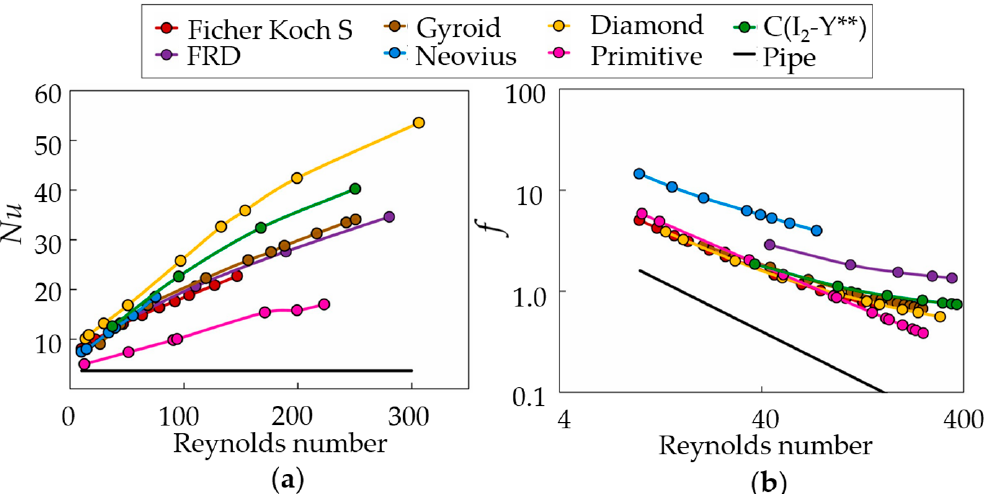
Figure 14 . Comparisons of the Nusselt number and friction factor of different TPMS topologies for the same infinitesimally thin walls (The correlations are provided by Iyer et al. [55]): ( a ) Averaged Nusselt numbers; ( b ) Friction factors.